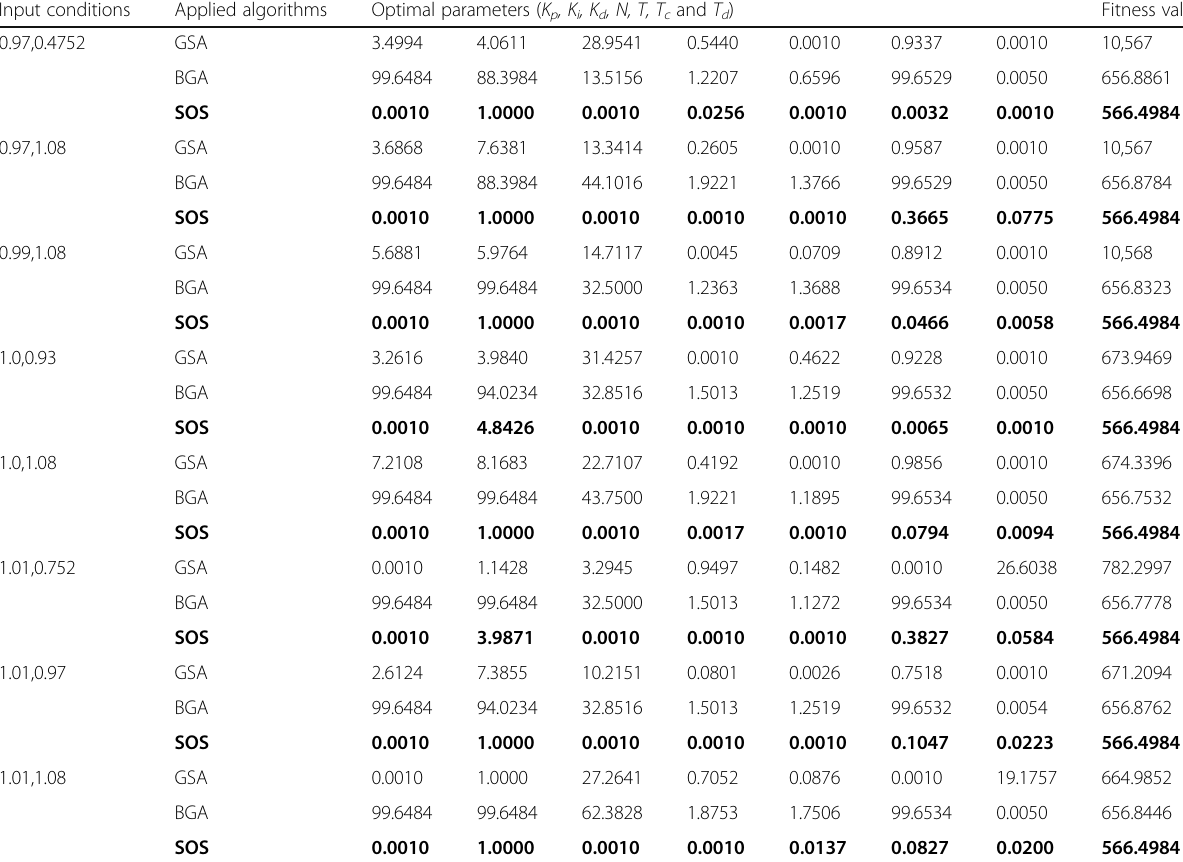
Table 1 Optimal controller parameter values and convergence values under different algorithms and input